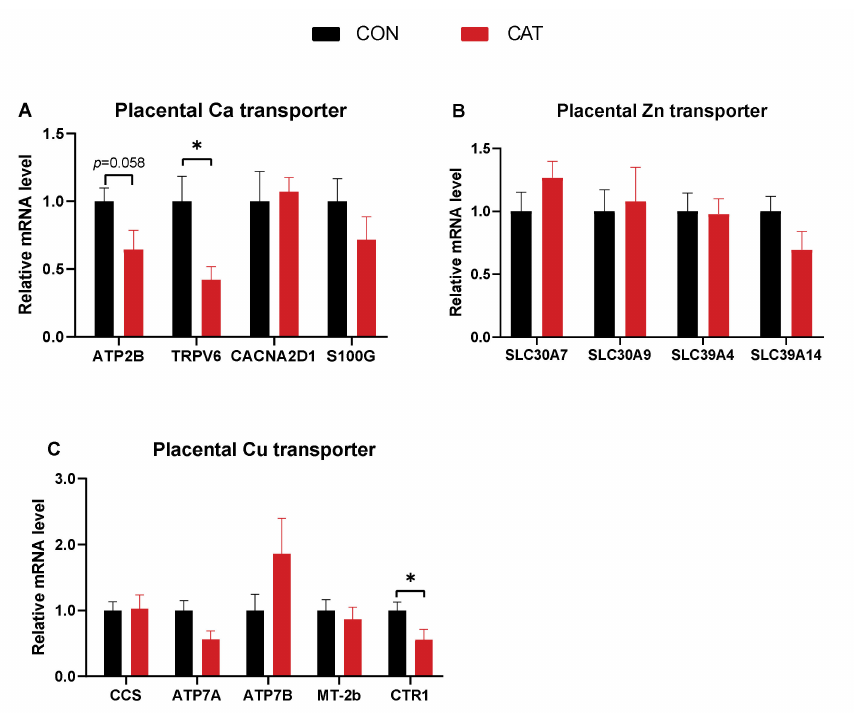
Figure 2. The effects of CAT on the mRNA expression of genes related to mineral transport in the placenta. ( A ): placental Ca transporter; ( B ): placental Zn transporter; ( C ): placental Cu transporter. Data are presented as mean ± SEM, n = 8. Statistical significance was set at p < 0.05 by t -test. * Denotes a significant difference at p <